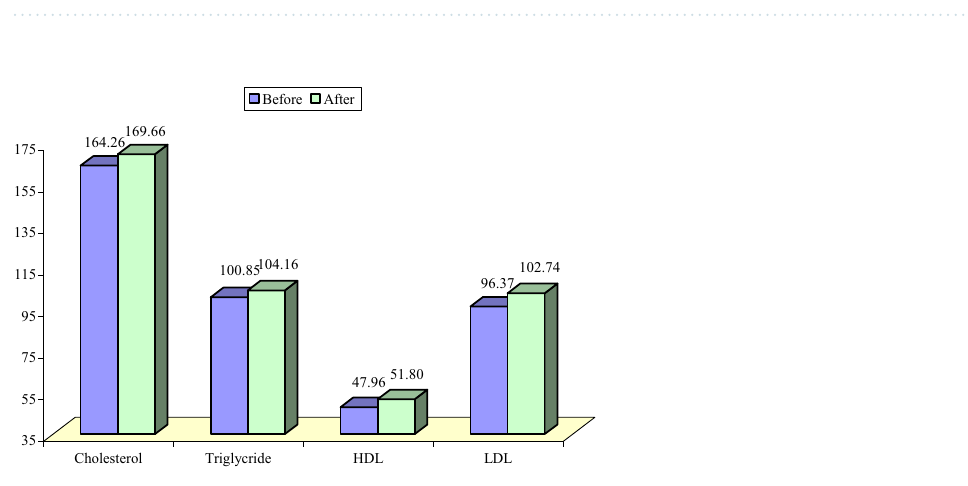
Table 3. Effect of KD on the adaptive behavior detected by using Vineland test in the studied patients.